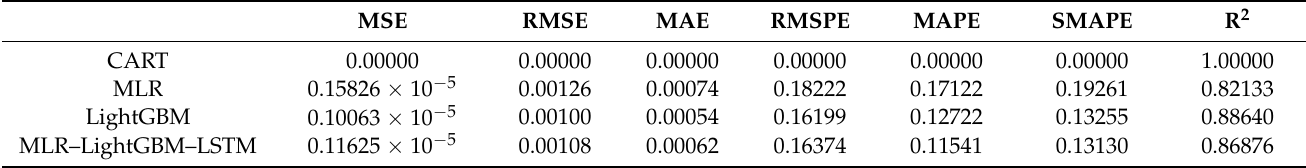
Table 5. Model bias comparison (based on the training set).